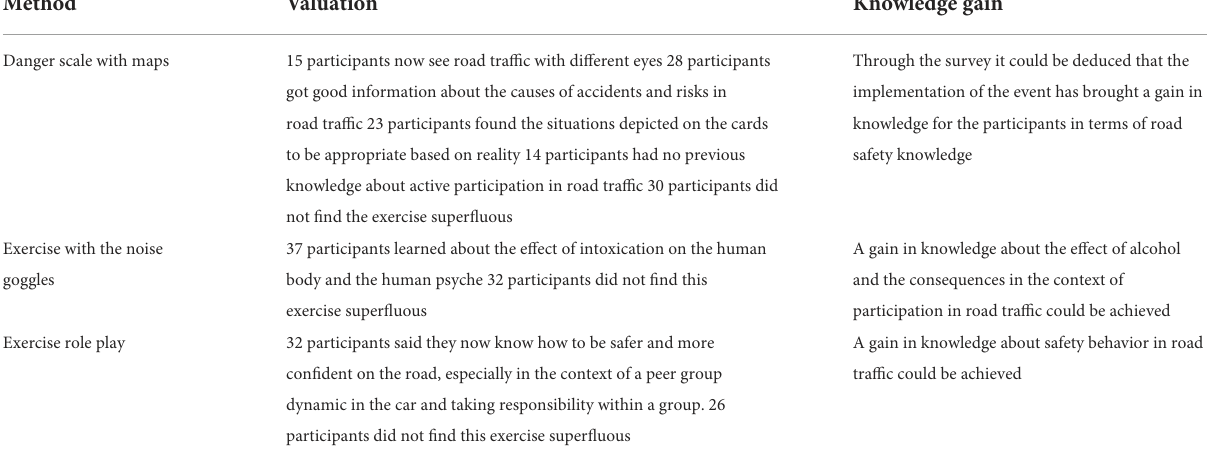
TABLE 2 Overview of the evaluation of the applied methods, n =